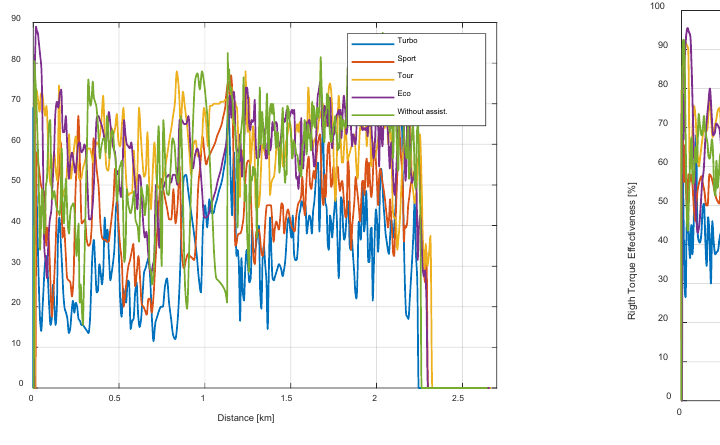
Figure 14. Left/right torque effectiveness.